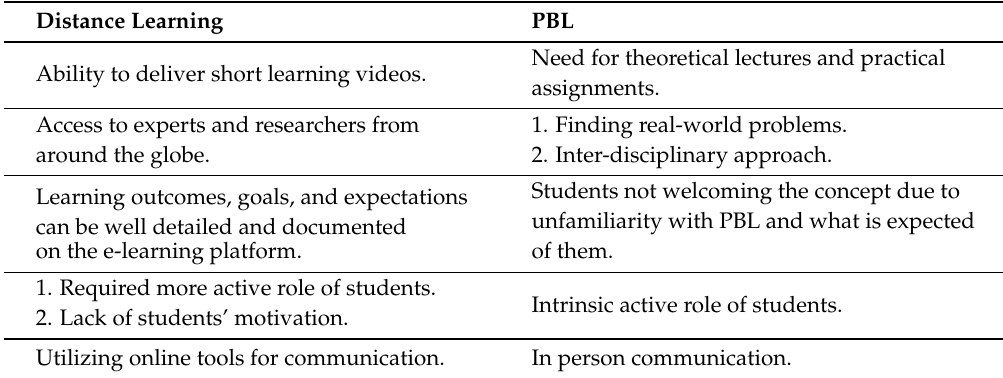
Table 6. Complementary attributes of distance learning and PBL in engineering education. Distance Learning